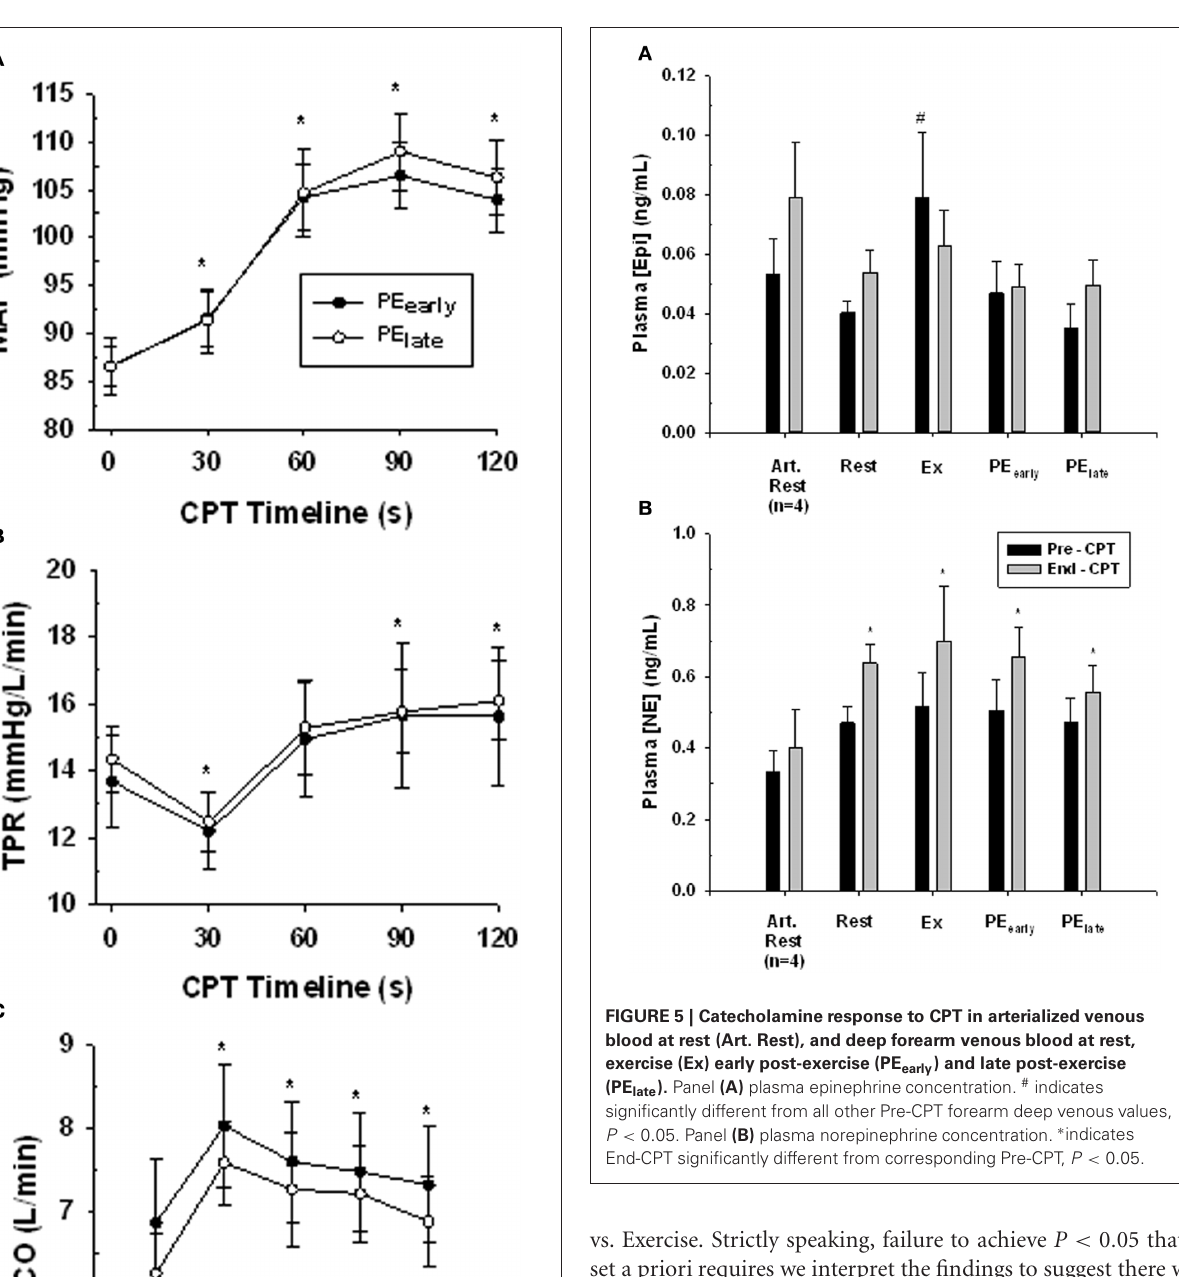
vs. Exercise. Strictly speaking, failure to achieve P < 0 . 05 that